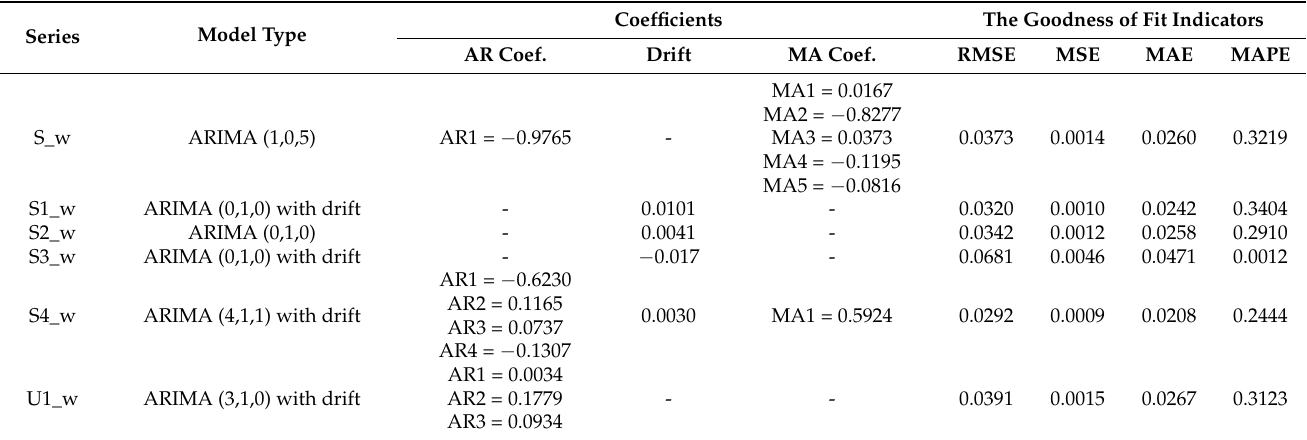
Table 22. ARIMA models for weekly series S_w, S1_w, S2_w, S3_w, S4_w, and U1_w.